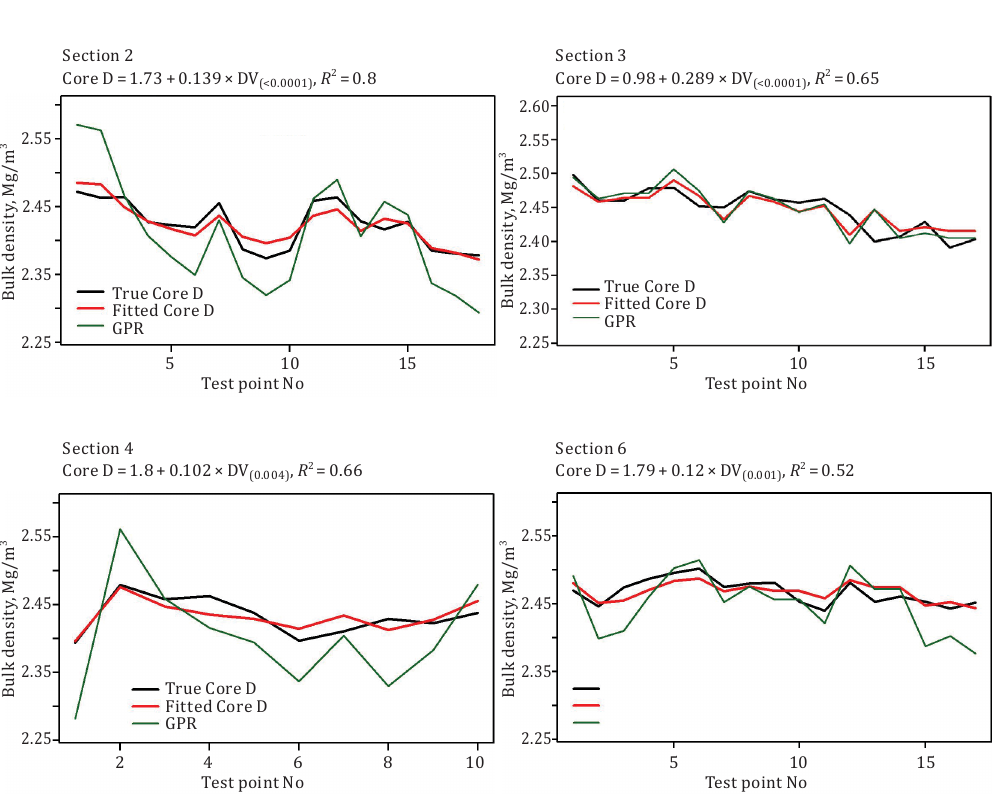
Figure 9. Graph of calculated asphalt density values obtained by different